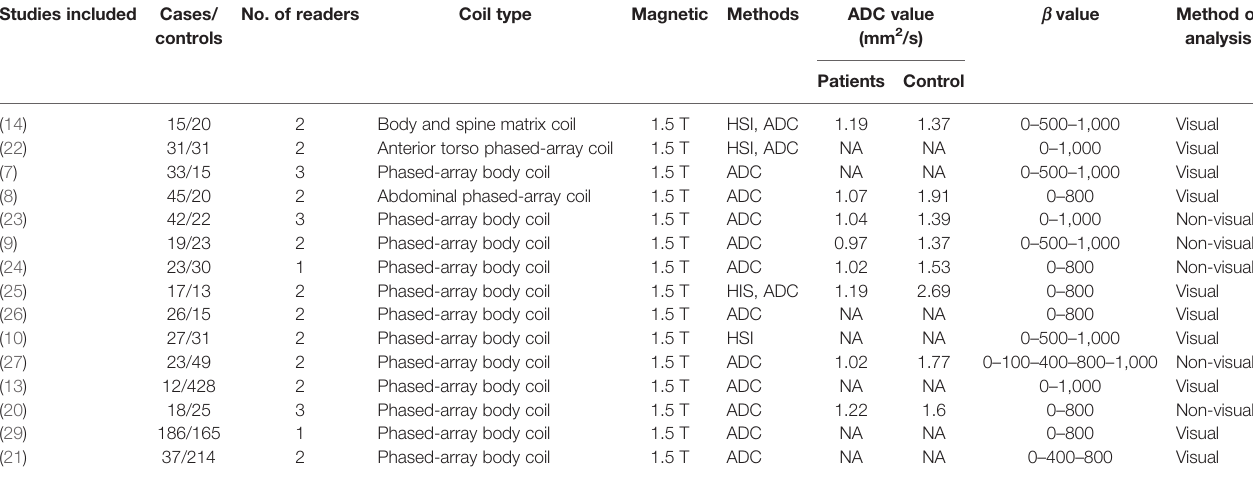
TABLE 2 | Characteristics of magnetic resonance imaging. Studies included Cases/ No. of readers controls